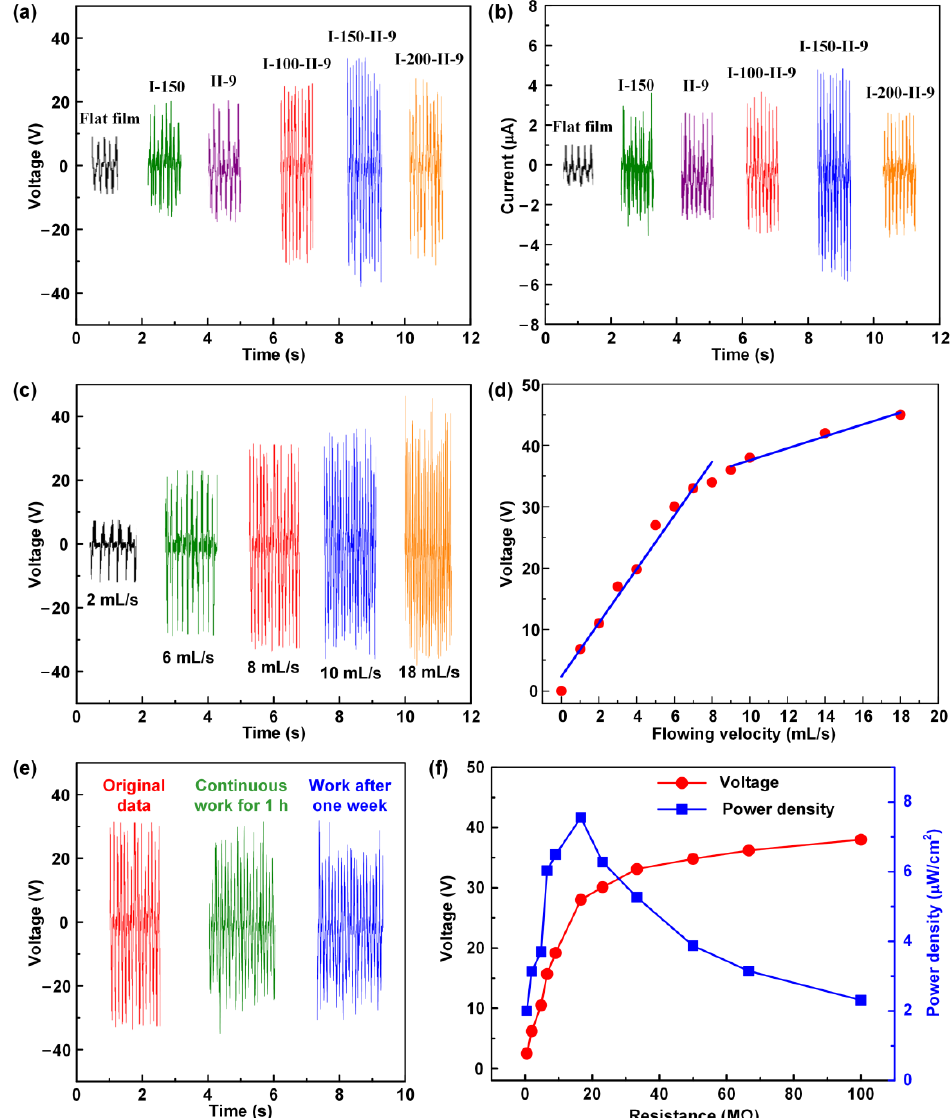
Figure 5. Output performance of water-solid contact TENGs. ( a ) Output voltage and ( b ) short-circuit current of water-TENGs based on the PDMS films with different morphologies at a flowing velocity of 8 mL/s. ( c ) Output voltages of the hierarchical structure I-150-II-9-based water-TENG at different flowing velocities. ( d ) Relationship between the output voltage and flowing velocity of the hierarchical structure I-150-II-9-based water-TENG. ( e ) Output voltages of the water-TENG device after continuous work for 1 h and when the test was conducted again after being placed for one week. ( f ) Output voltage and power density curve across different resistive loads for the hierarchical structure I-150-II-9-based water-TENG device at a flowing velocity of 10 mL/s.